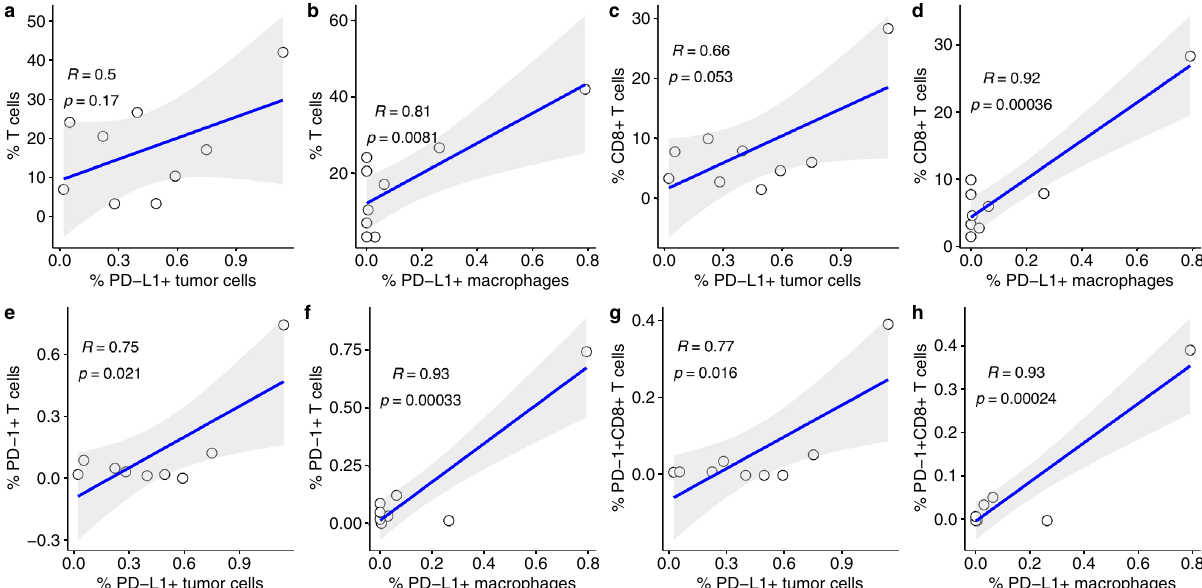
Fig. 6 Densities of pre-treatment T cell populations correlated with pre-treatment PD-L1 + cell populations. Correlation plots of pre- treatment densities of total T cells ( a , b ), CD8 + T cells ( c , d ), PD1 + T cells ( e , f ), and PD1 + CD8 + T cells ( g , h ) with pre-treatment densities of PD- L1 + macrophages ( b , d , f , h ) and/or PD-L1 + tumor cells ( a , c , e , g ) are shown. R and p from Pearson ’ s correlation. Gray shaded area represents 95% con fi dence